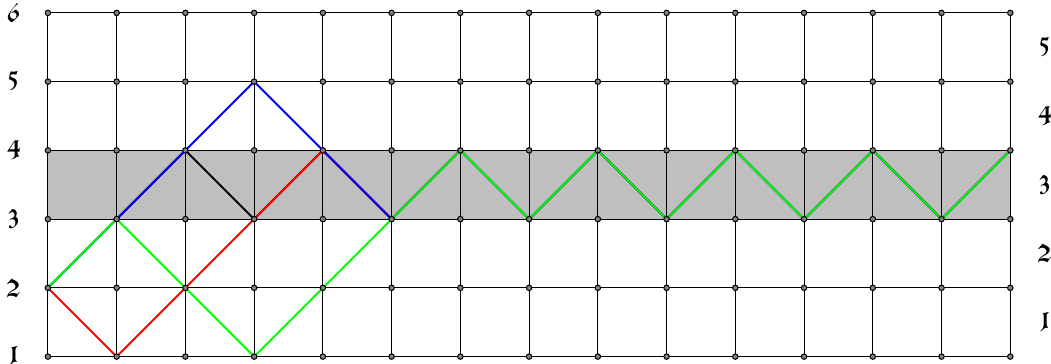
Figure 15 . Several paths in the next-to-vacuum module of the restricted solid-on-solid model L 2 ; 7 , labeled by a = 2, b = 3, and c = 4. The minimal path in black, the path with weight 1 in red, and two paths with weight 3 in blue and